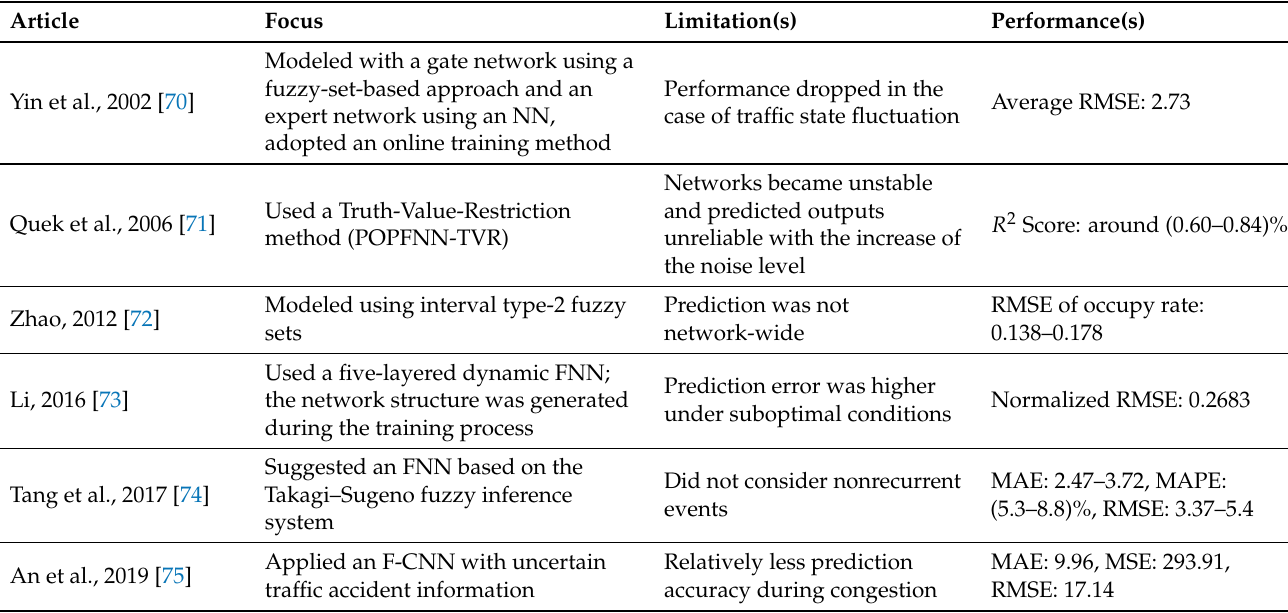
Table 10. Summary of the works found using FNNs.